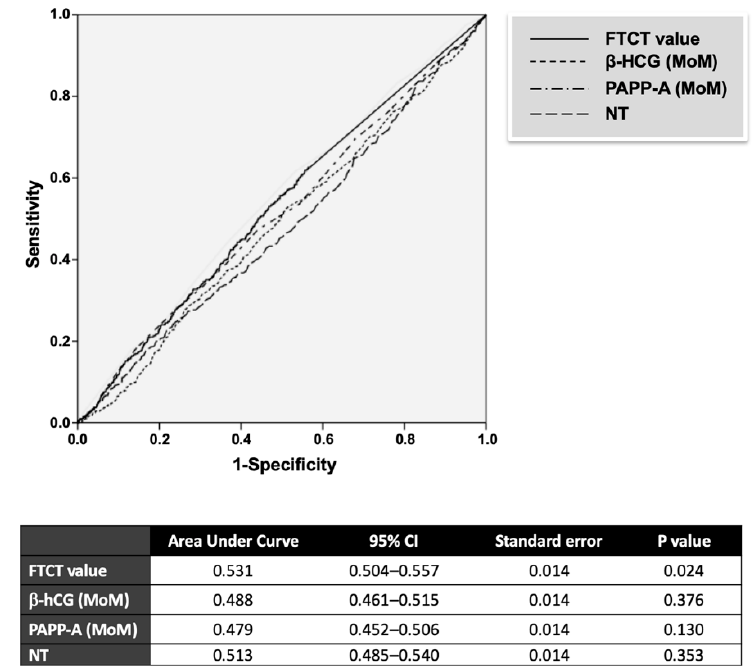
Figure 2. Receiver-operating-characteristic (ROC) curves of FTCT parameters for the prediction of GDM. β -hCG: β -human chorionic gonadotropin; PAPP-A: pregnancy-associated plasma protein A; NT: nuchal translucency.